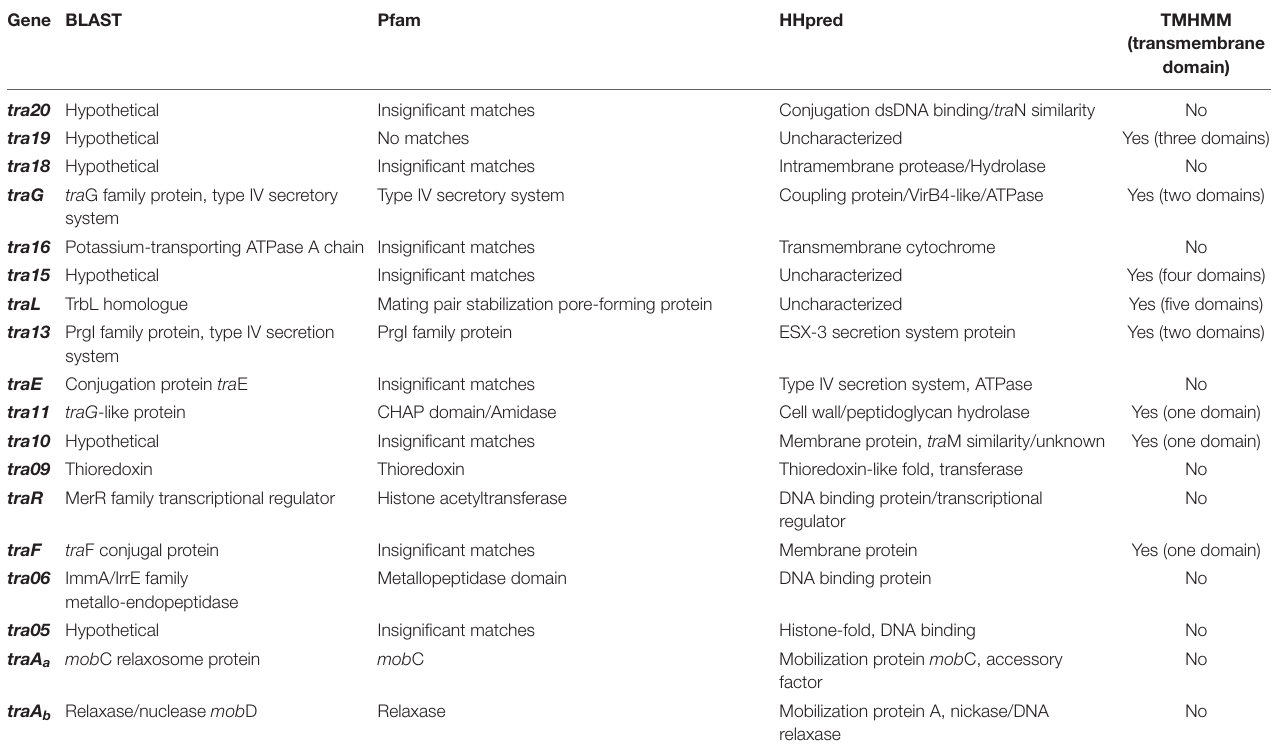
TABLE 2 | Functional analysis of the genes from the pNP40 conjugation cluster, based on amino-acid and protein sequence comparison using BLAST and Pfam v32.0, TMHMM for the prediction of transmembrane helices in proteins and HHpred to assign function based on structure prediction. Gene